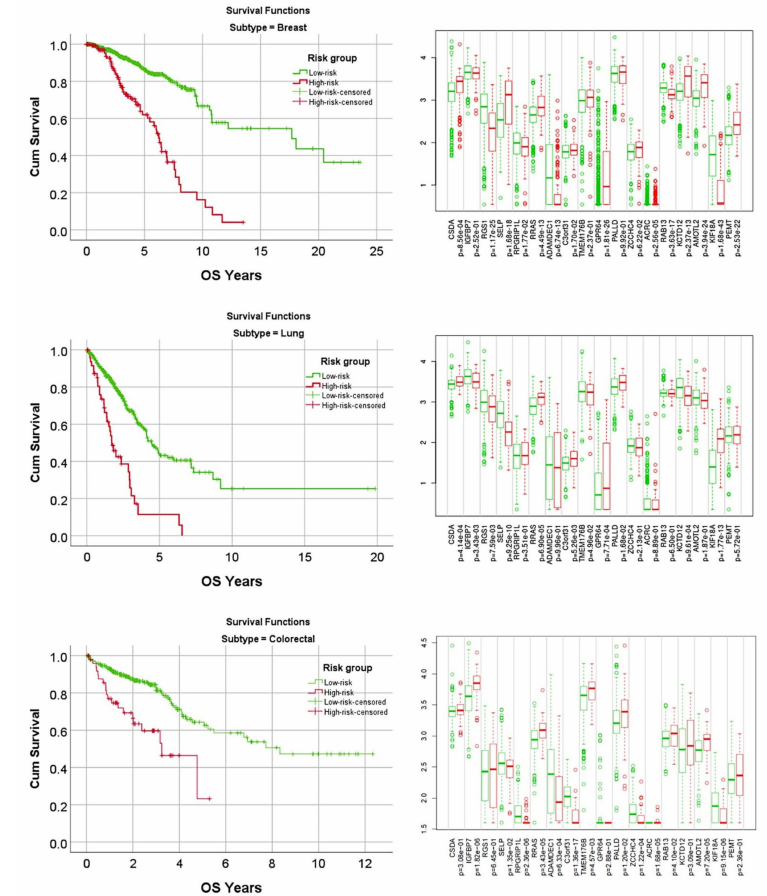
Figure A1. Differential gene expression of the set of 19 genes per cancer subtype. Based on a risk- score formula and the gene expression of 19 genes, the overall survival for each risk-group could be calculated. The contribution in the prognosis for each gene is shown on the right. This Figure is complementary to Figure